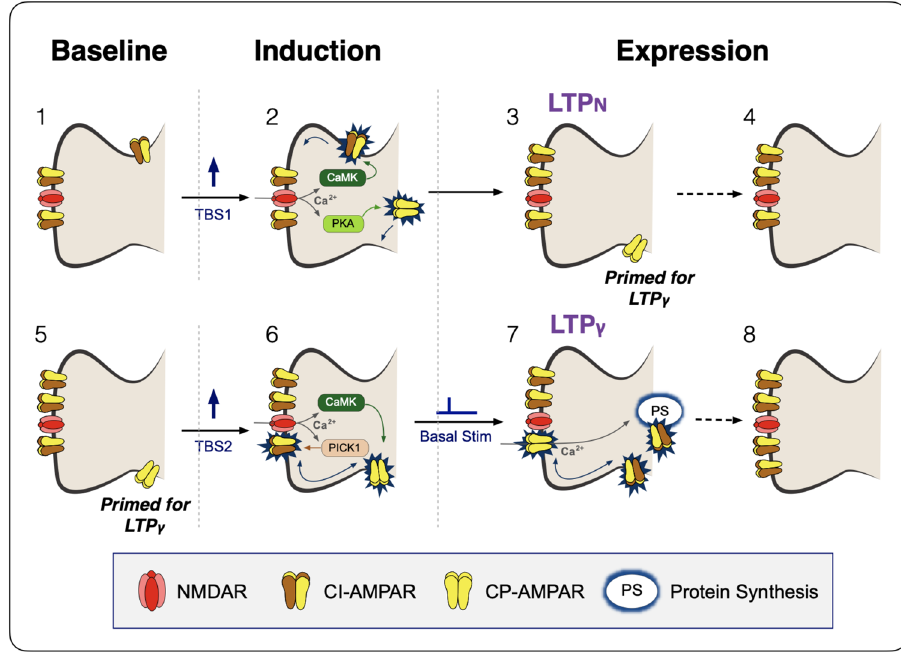
Fig. 8 Schematic outlining the induction of two mechanistically distinct forms of LTP. 1 Under baseline conditions synaptic transmission is mediated by GluA2-containing, calcium-impermeable (CI)-AMPARs, two shown for simplicity. 2 The fi rst theta-burst stimulation (TBS) activates NMDA receptors (NMDARs) and this drives more CI-AMPARs into the synapse by lateral diffusion from a peri-synaptic pool, via a process that involves CaMKII. PKA is also activated (via adenyl cyclase, not shown) and this induces the process of inserting GluA2-lacking calcium-permeable (CP)-AMPARs into peri-synaptic sites on the plasma membrane. 3 LTP is expressed by the increase in number of CI-AMPARs (LTP N ) but synapses also become primed for LTP γ by the availability of peri-synaptic CP-AMPARs. 4 Within ~1 h, the peri-synaptic CP-AMPARs are removed and, presumably, degraded. 6 If a second TBS is delivered whilst the synapses are still primed ( 5 ) then NMDAR activation drives the peri-synaptically located CP-AMPARs into the synapse, via a CaMKII- dependent process. This might involve an exchange of CP-AMPARs for CI-AMPARs, which are removed from the synapse via a mechanism triggered by PICK1. 7 These CP-AMPARs increase synaptic strength due to their higher single channel conductance (LTP γ ). However, their dwell time in the synapses is quite short (~15 min) before they are removed. If synapses remain active, such as by basal stimulation, activation of the transiently available, synaptic CP-AMPARs triggers protein synthesis and the insertion of more CI-AMPARs ( 8 ), which can extend the expression of LTP for long